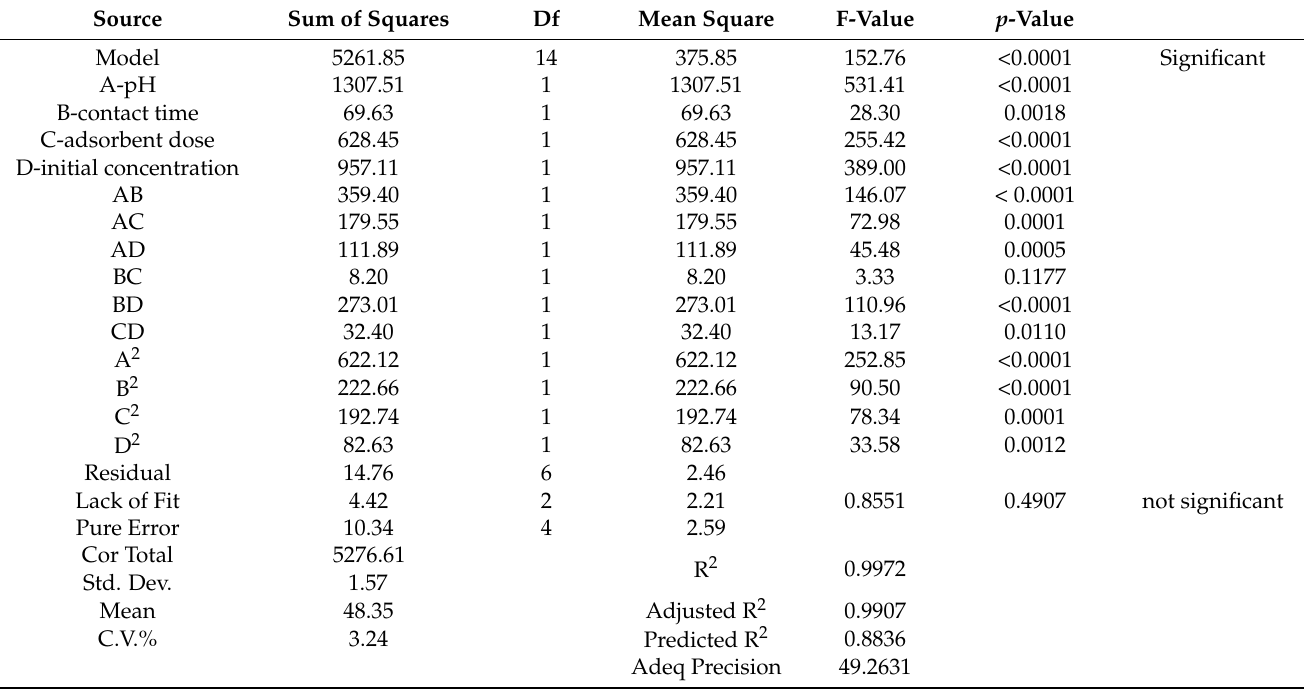
Table 7. Analysis of variance (ANOVA), test of significance for 2,4-D adsorption on termite mound